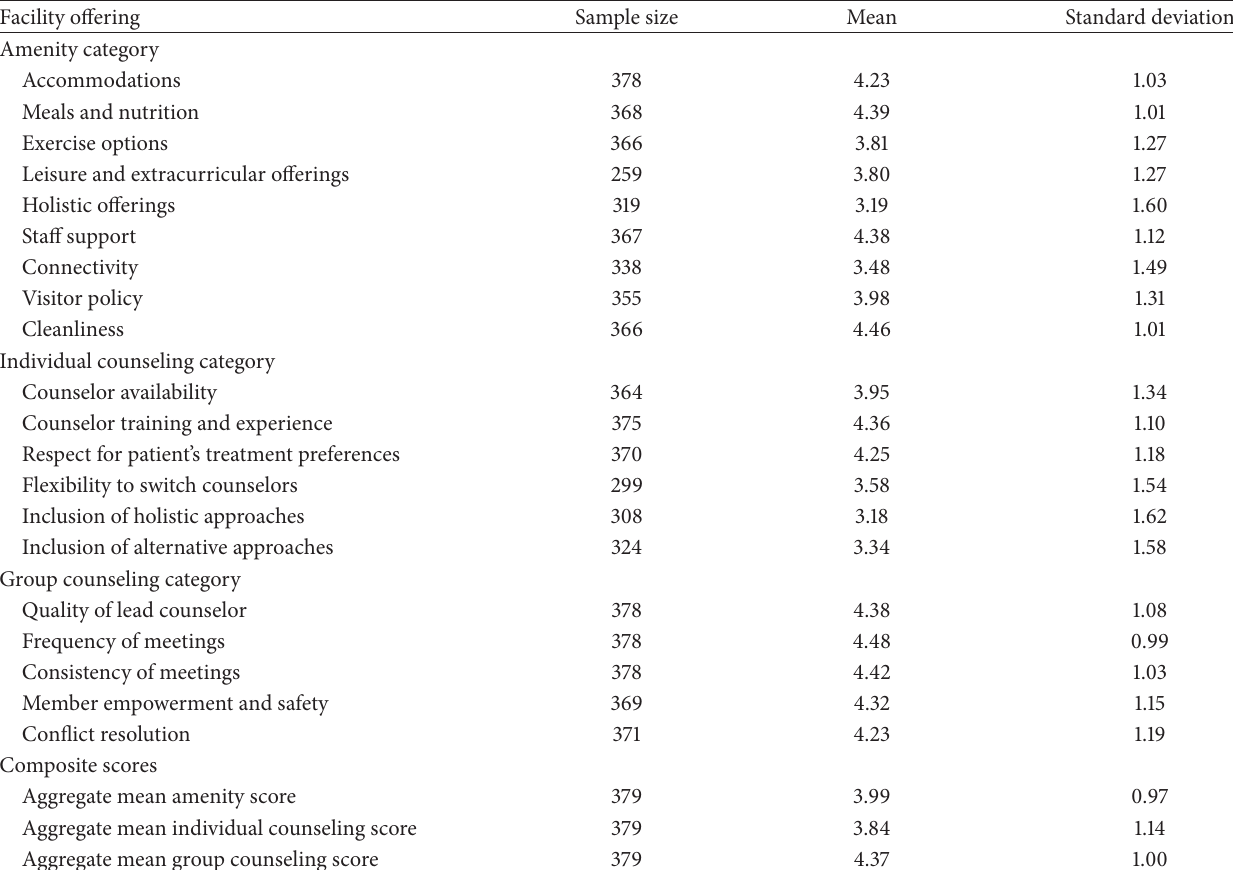
Table 2: Mean values for respondent’s ratings of facility offerings.